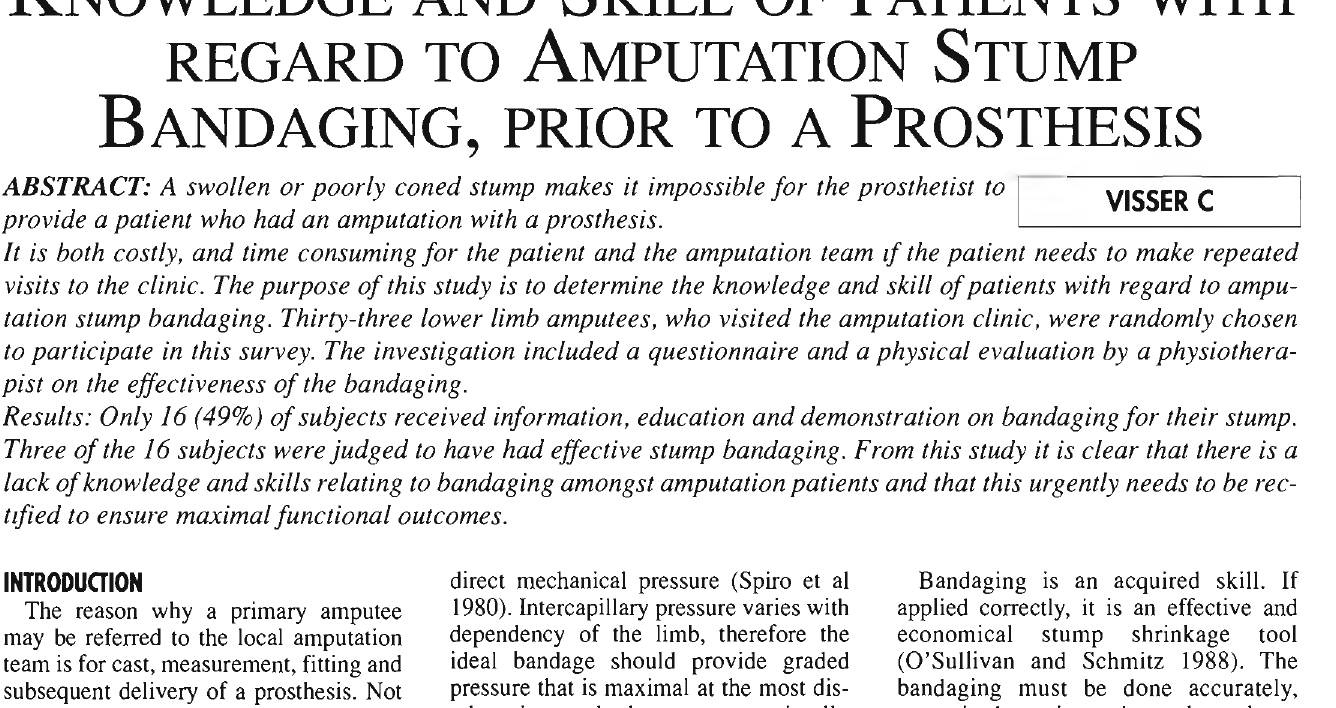
FIGURE 1 Demonstration and education on the bandaging of the amputation